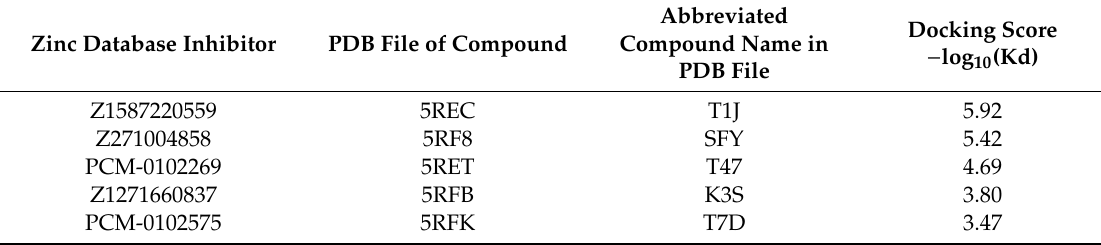
Table2. DockingscoresofsuccessfullydockedzincdatabasecoronavirusinhibitorsfromPDBstructures.